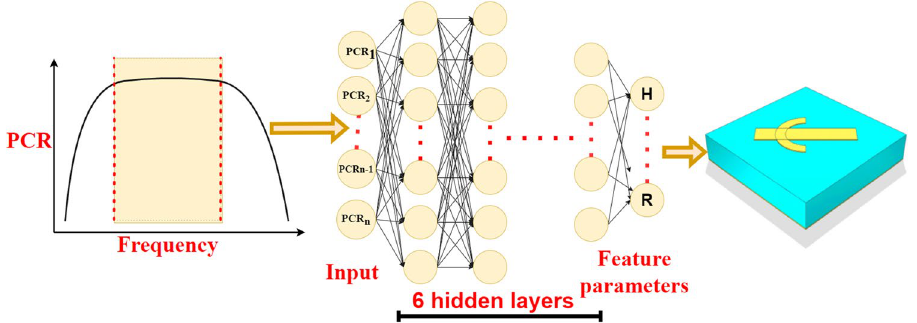
Figure 5. Illustration of the deep neural network (DNN) model. The target PCR spectrum is used as the input layer at the left end, the 7-layer DNN network is in the middle, and the metamaterial structure parameters is at the right side as the output.